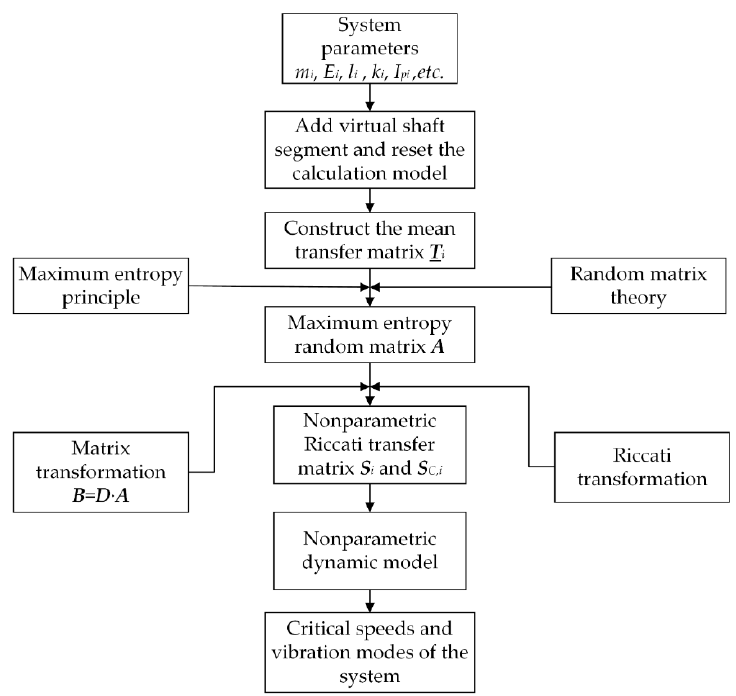
Figure 3. Flow chart for calculating the natural characteristics of the system.